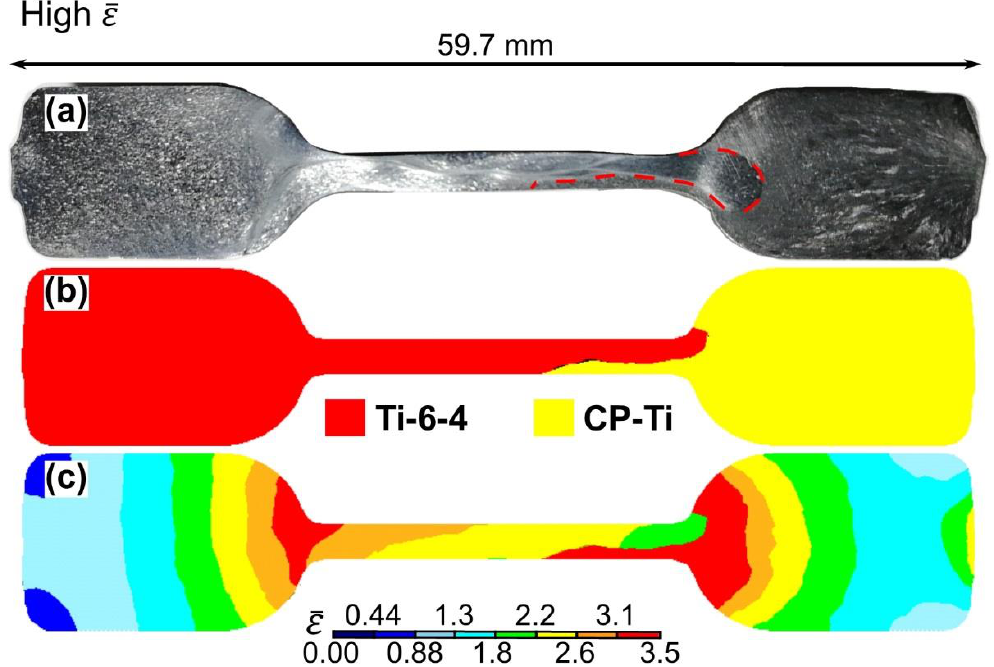
Figure 14. ( a ) Photograph of the high strain cross-section of the eye-bolt 1 forging from Figure 10b; ( b ) ccorresponding simulation showing the alloy distribution; and ( c ) the corresponding simulation showing the effective strain distribution. Approximate forging temperature between 860 and 878 °C, with a total of nine hammer steps.